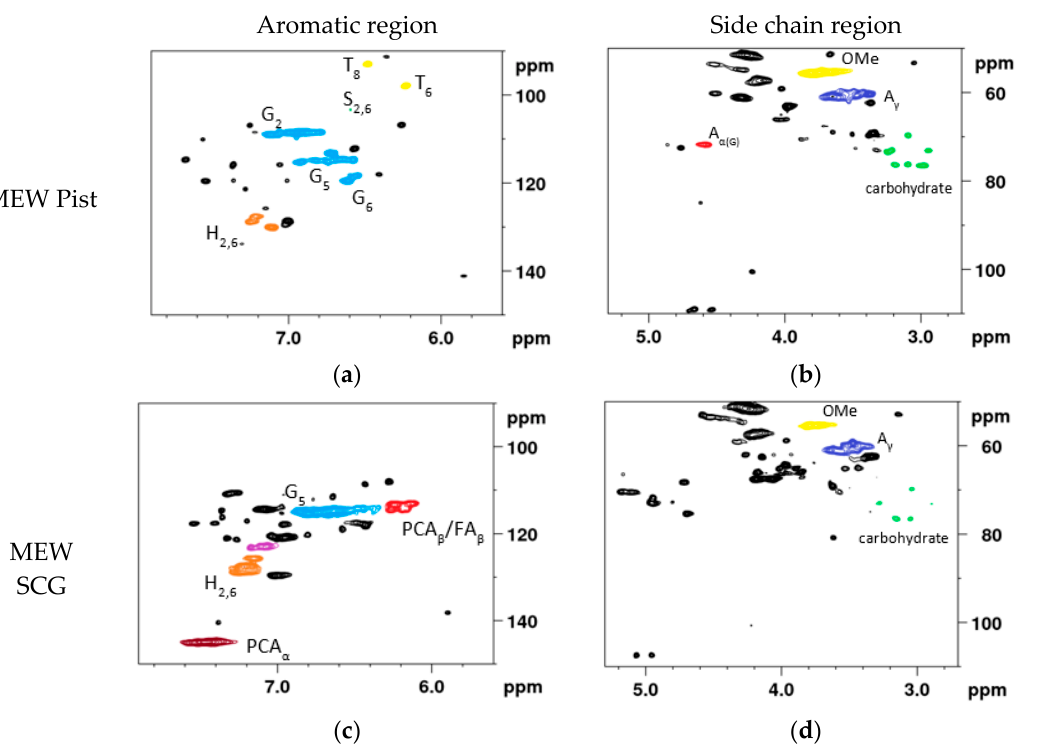
Figure 5. A 2D NMR analysis of LEF samples obtained using MAW. See Table 5 for label assignments.